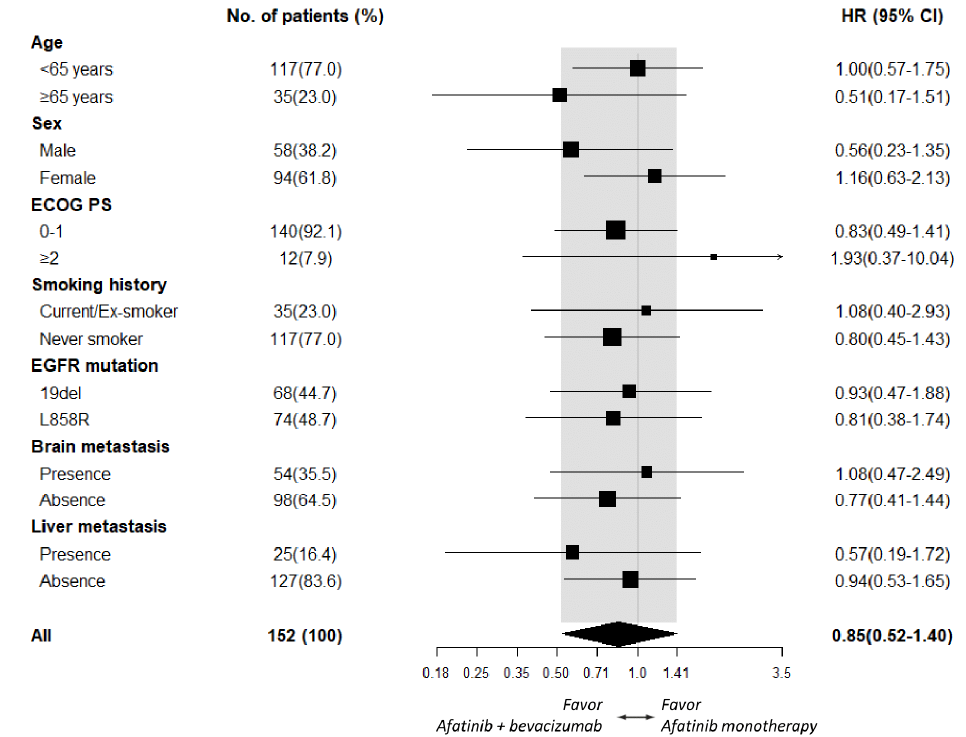
Figure 2. Subgroup analysis of PFS between the afatinib plus bevacizumab and the afatinib monotherapy groups.